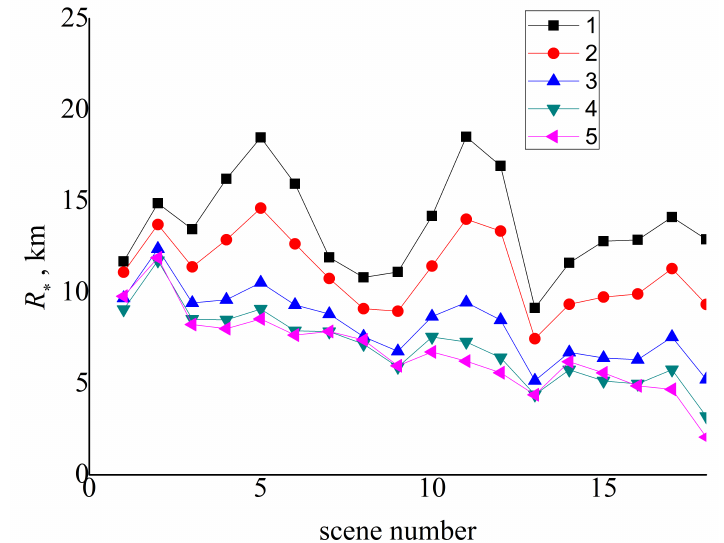
Figure 4. Image-averaged radius of the cloud adjacency effect (CAE radius) for 18 scenes: (1) MODIS band 8, (2) MODIS band 3, (3) MODIS band 4, (4) MODIS band 1, and (5) MODIS band